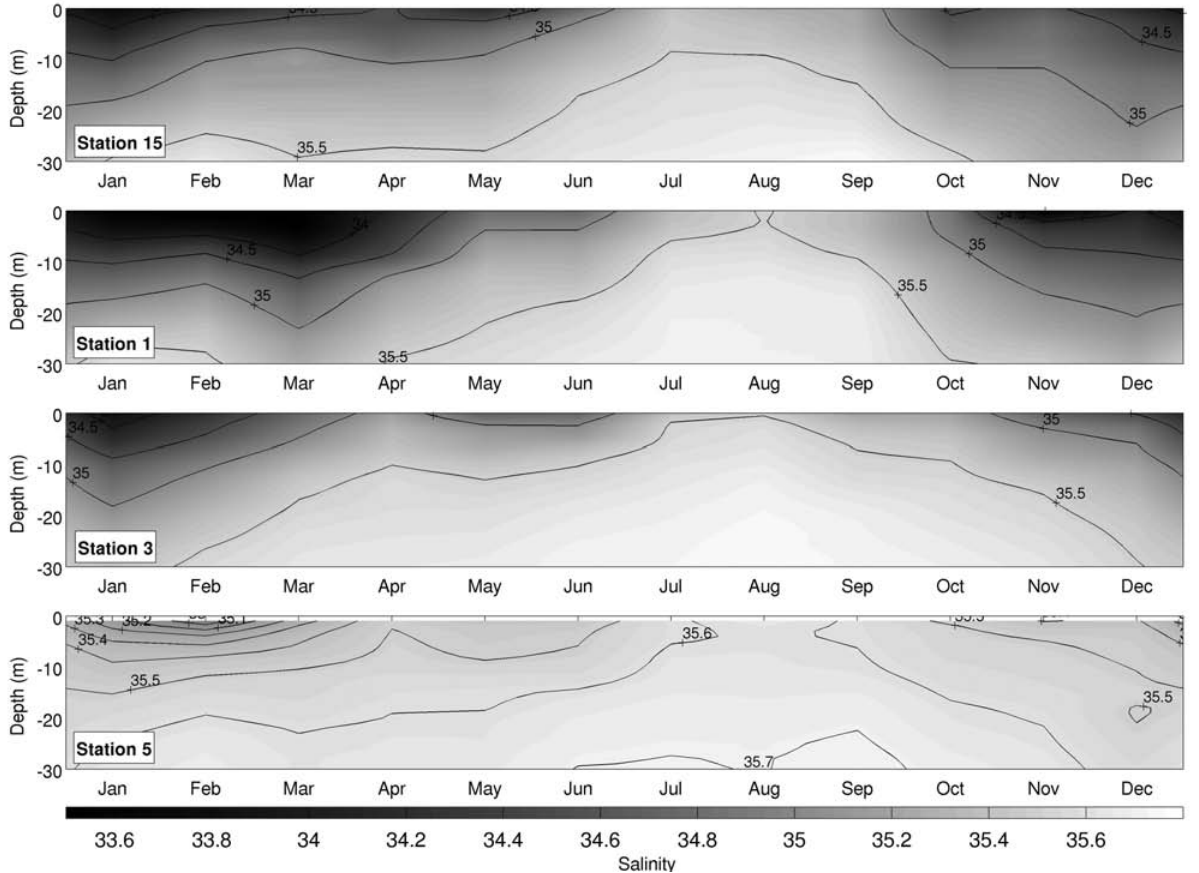
Fig . 11. – Long-term salinity annual cycle computed for the four sampled stations. Data are limited to 30 m depth (the maximum depth of the shallower station) to facilitate the comparison. Cyclic behavior is imposed at the start and end of the